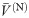
Control parameter regulated the chaoticity in the target’s motion.(A) Representative trajectories of the target [x, y] (red) and cursor [xc, yc] (blue). As the control parameter setting a was elevated, increased folding and irregularity became more evident, resulting in lower tracking accuracy. (B) Normalized cursor velocity magnitude V¯(N) as a function of the block number. V¯(N) tended to increase over time. (C) Probability density function V¯ in the first and last blocks showed reduced incidence of low-velocity movements with practice. *** represents p < 0.001.